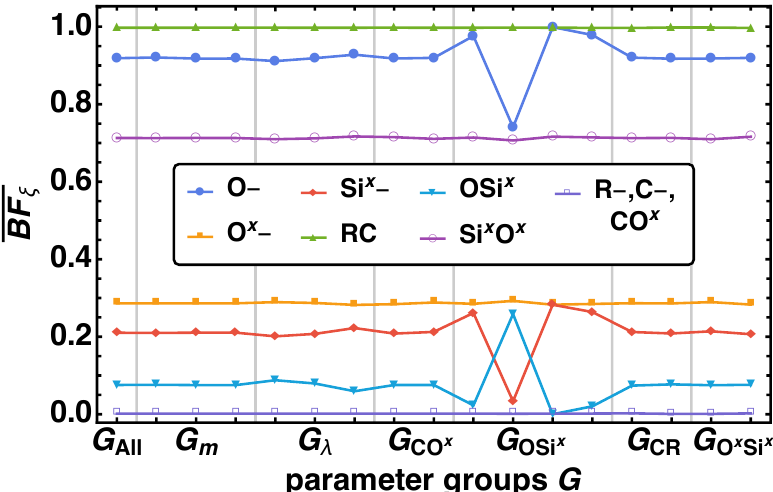
Figure 6. Averaged bond fractions BF ξ at t fin for all non-bonded reaction center ξ = { O–, C–, R–, O x –, Si x – } and bond vector types ξ = { CO x , CR, OSi x , Si x O x } over the parameter groups G ( i ) specified in Table